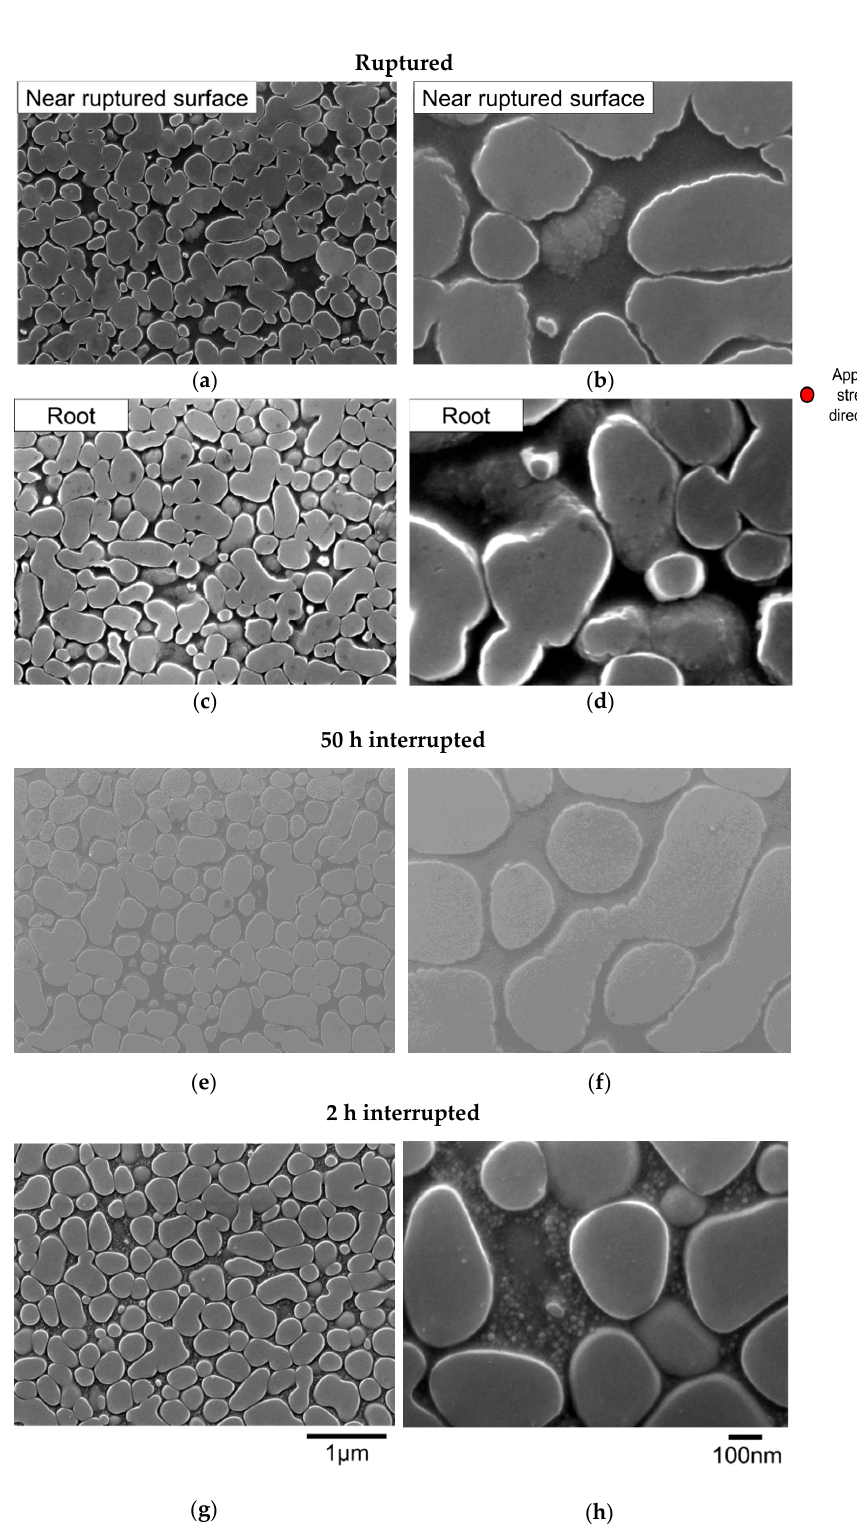
Figure 8. Relationship between the aspect ratio of the γ′ precipitates and distance from the rup- tured surface.